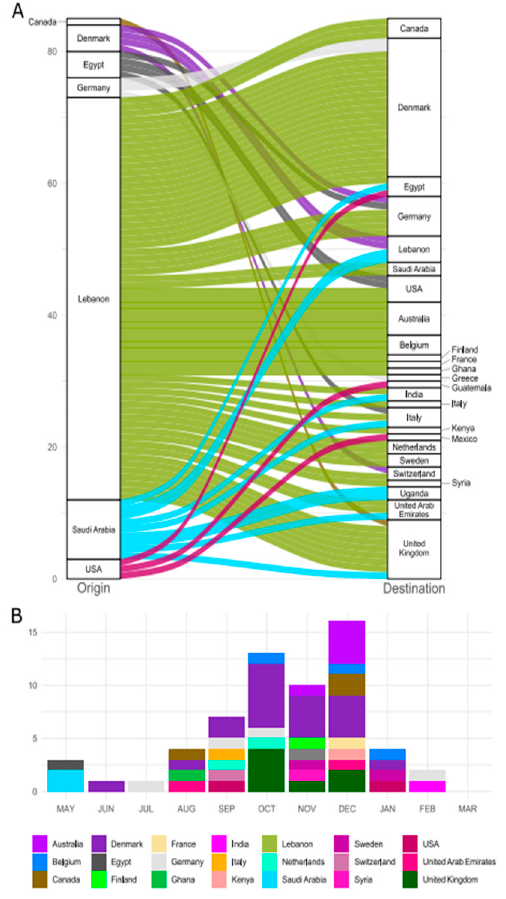
Figure 2. International dispersal of the B.1.398 lineage. In ( A ), all the international transmission routes are represented, with the left bar being the countries of origin of dispersal, the right bar their destinations, and the color of dispersal representing the originating country. In ( B ), the temporal distribution of countries receiving B.1.398 that originated in Lebanon is displayed. The legend for both graphs is located at the bottom.